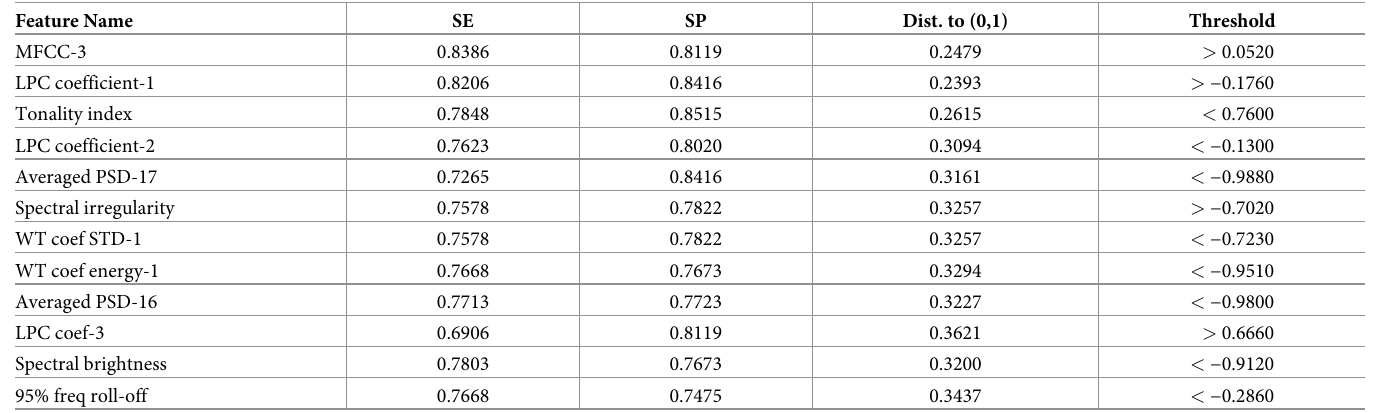
Table 3. Comparison of optimum ROC points of features with the highest AUC.